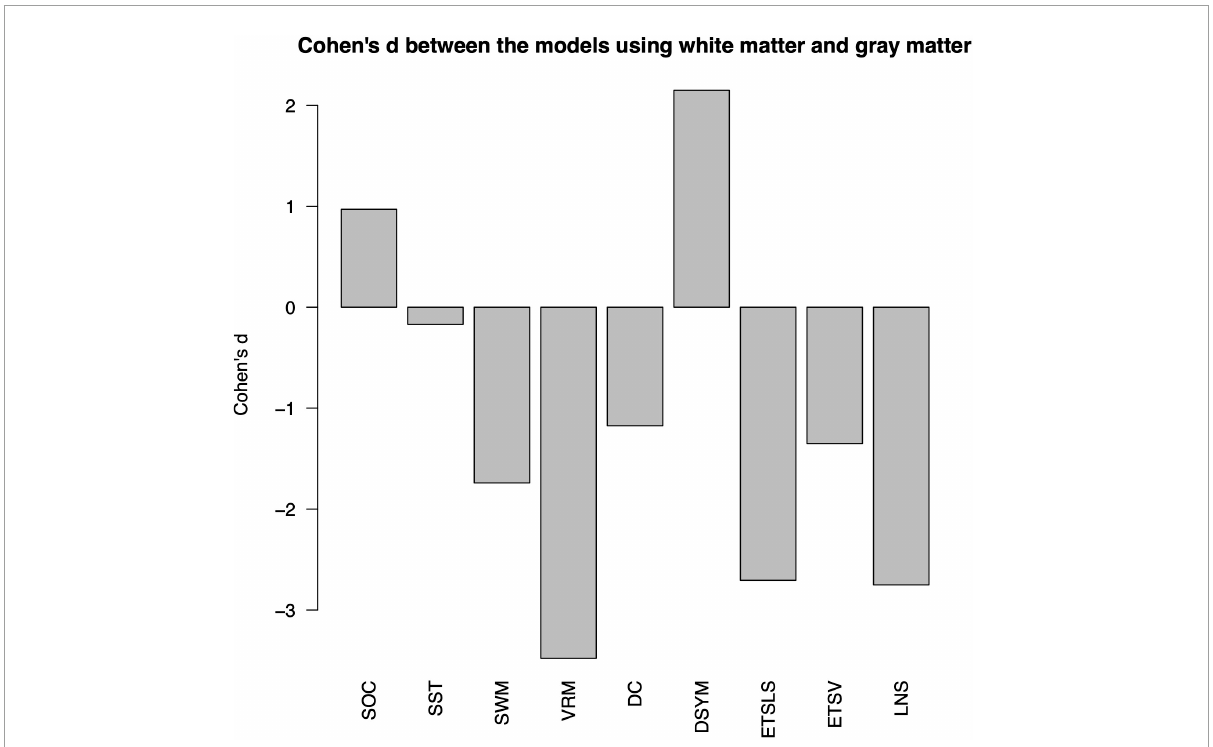
FIGURE4 Comparisons of predictive models based on white matter and gray matter. The nine cognitive predictive models contain the Stockings of Cambridge (SOC), the stop signal task (SST), the spatial working memory (SWM), the verbal recognition memory (VRM), the digit comparison (DC), the digit symbol (DSYM), the ETS advanced vocabulary (ETSV), the ETS letter sets (ETSLS), and letter number sequencing (LNS),